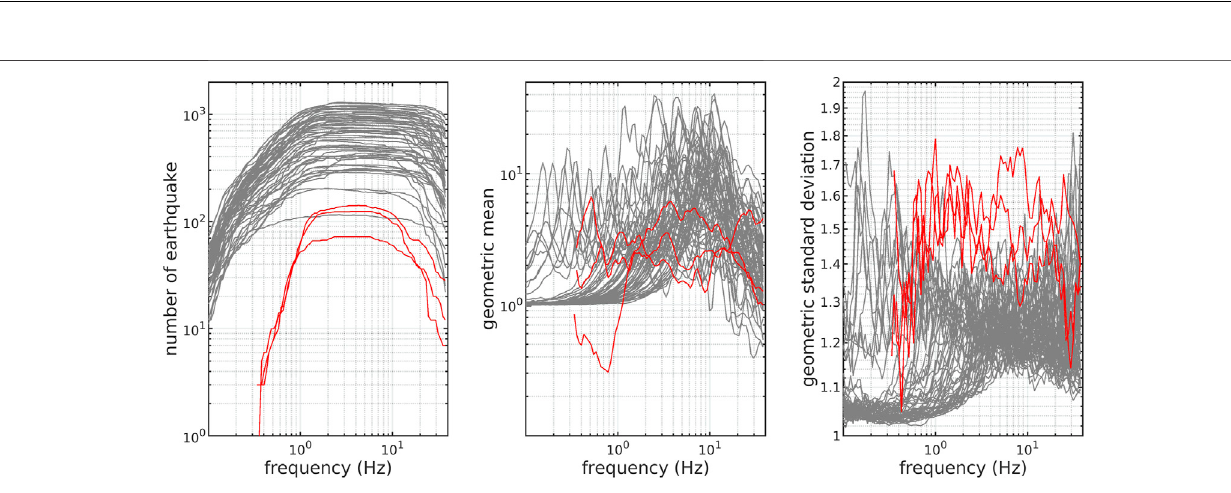
Frontiers in Earth Science |